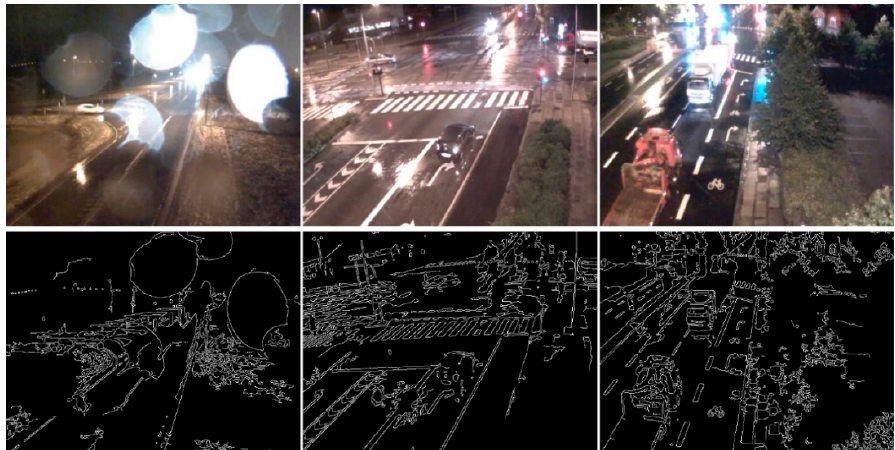
Figure 1. Some examples of poor imaging conditions, the top images are the RGB images, and the bottom images are the images after edge detect. There is a lot of interference information in the edge information under the influence of light and reflection, in these cases the object detector may miss an object or detect a wrong object.